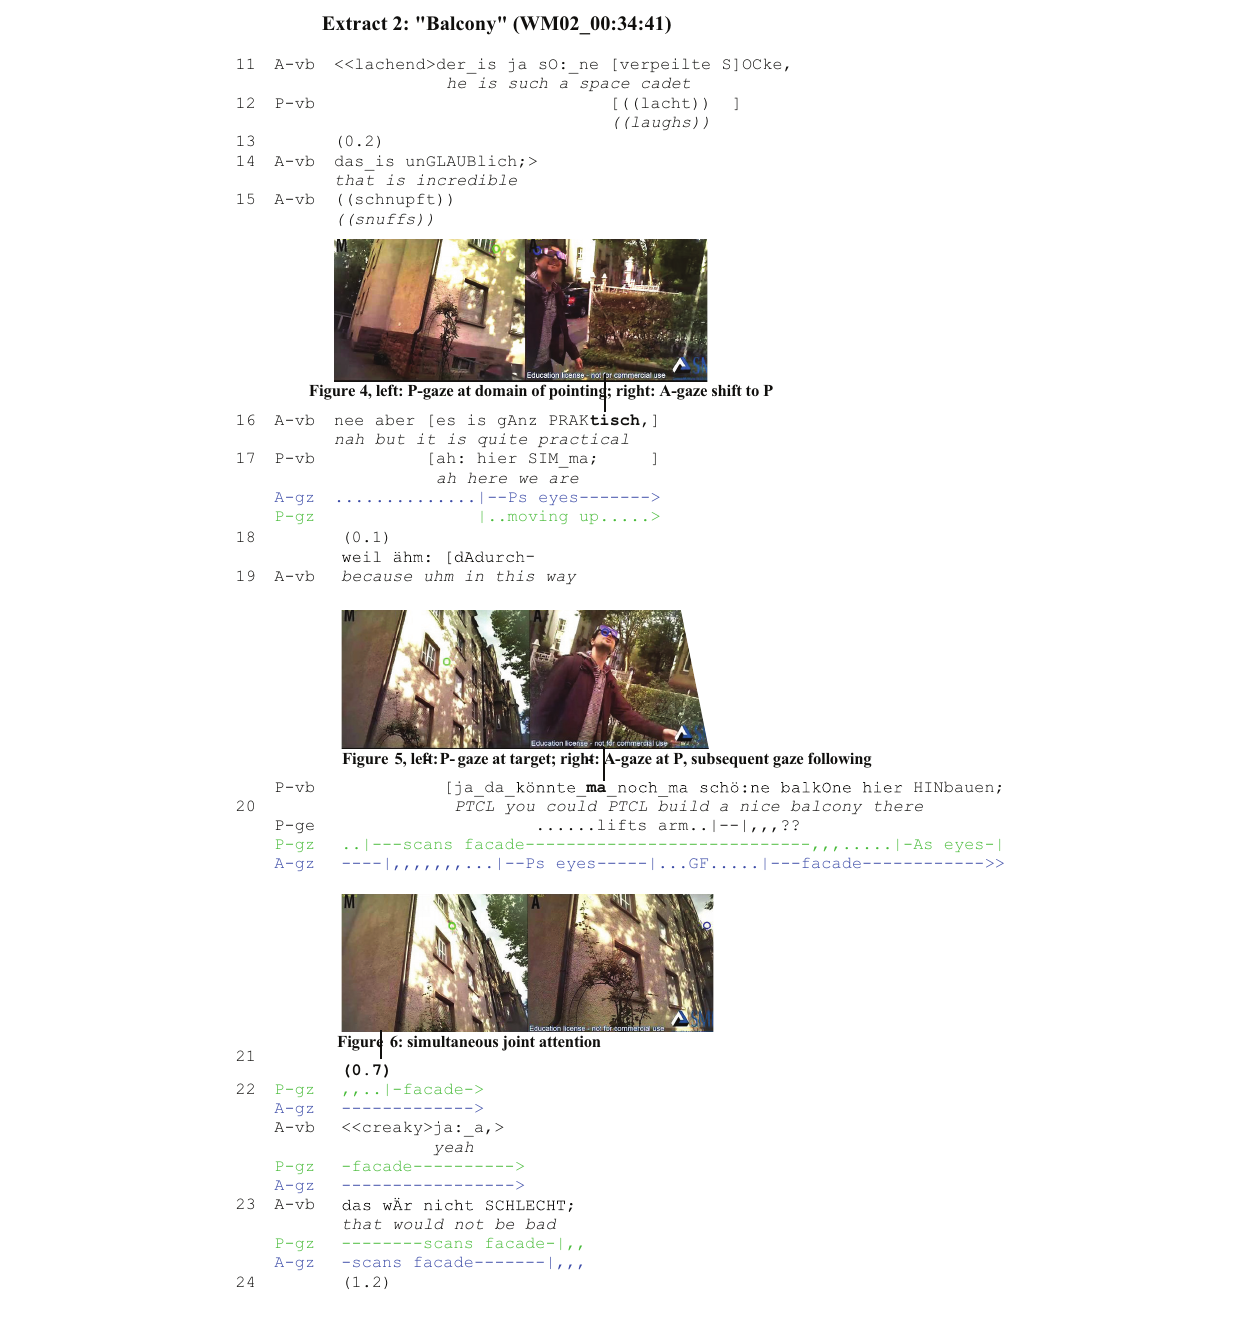
Figure 6: simultaneous joint attention